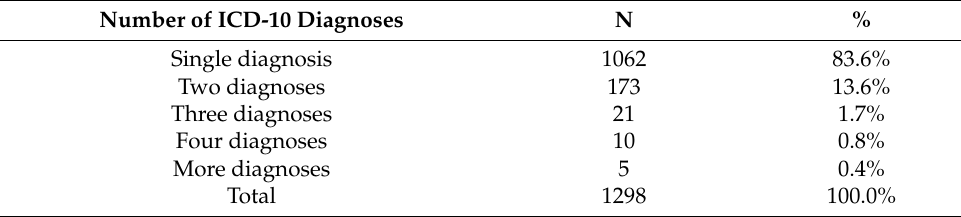
Table 5. The number of diagnoses (a single patient diagnosed with two or more diseases).